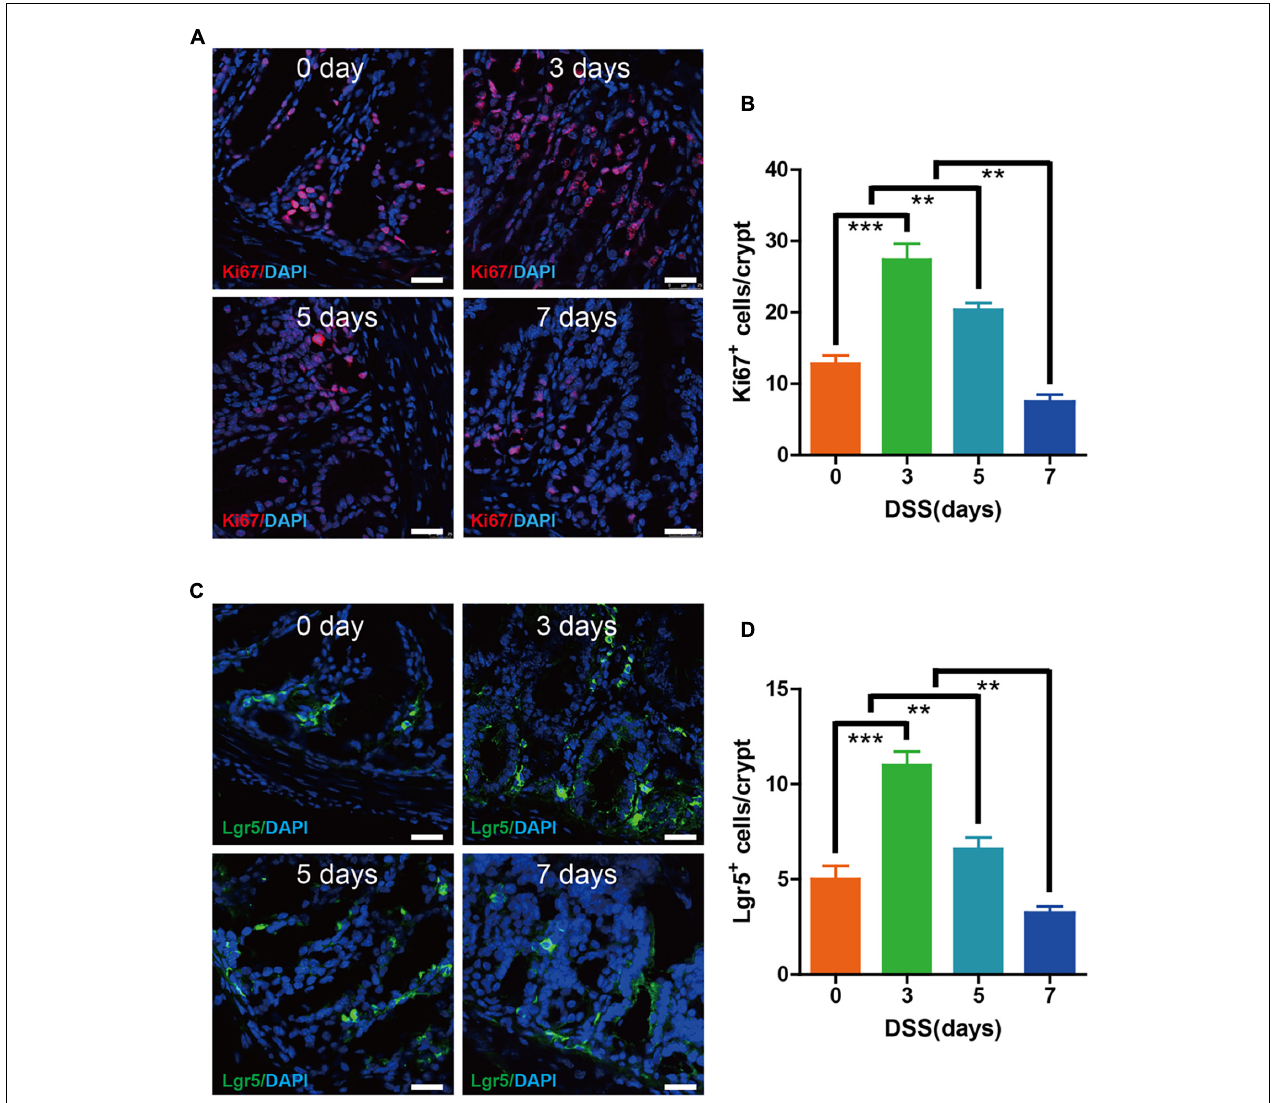
FIGURE 2 | Epithelium cell proliferation and Lgr5 + stem cell maintenance were preserved during the early 3 days of DSS colitis. (A) Immunofluorescence staining for Ki67 in colon tissue from mice treated with DSS at 0, 3, 5, and 7 days (red: Ki67, blue: DAPI). (B) Quantification of Ki67-positive cells per crypt ( n = 5). (C) Immunofluorescence staining for Lgr5 in colon tissue from mice treated with DSS at 0, 3, 5, and 7 days (green: Lgr5, blue: DAPI). (D) Quantification of Lgr5-positive cells per crypt ( n = 5). Data represent mean ± SD with three independent experiments. One-way ANOVA and Bonferroni test for multiple testing was applied in all cases. ** p < 0.01, *** p < 0.001. Scale bar = 25 µ